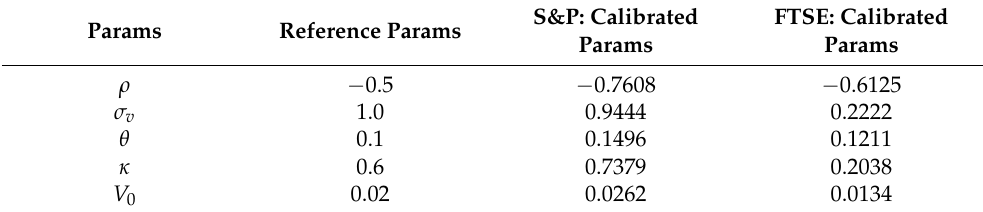
Table 2. Reference parameters and calibrated parameters for the Heston model.